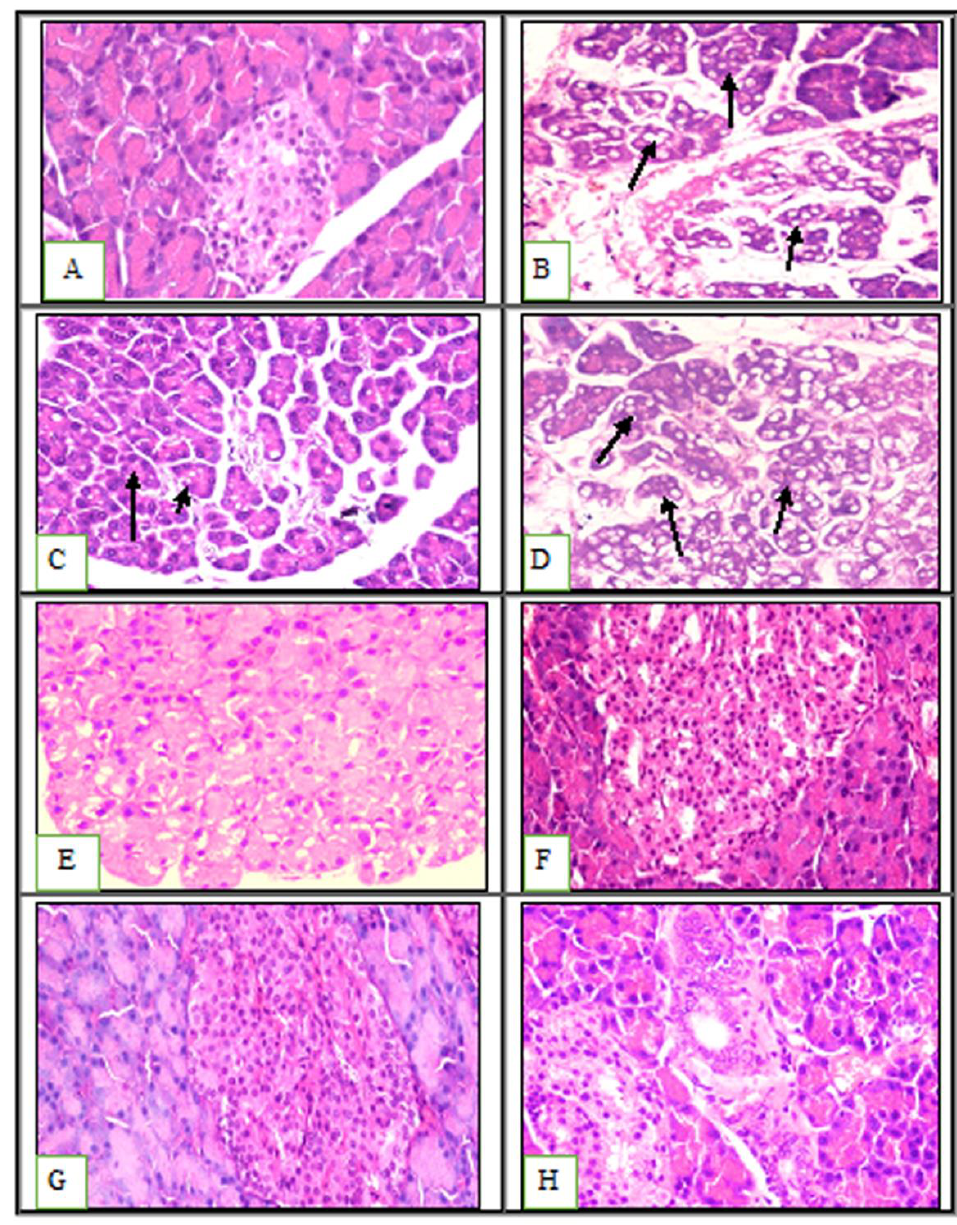
Figure 5. Histopathological examination of the pancreatic tissue. ( A ) Normal pancreatic tissue (H & E X400). ( B ) Massively vacuolated acinar epithelium (arrows) (H & E X400). ( C , D ) Partially vacuolated acinar epithelium (arrows). ( E – F ) Normal pancreatic tissue (H & E X400). ( A ) Negative control. ( B ) Positive control. ( C , D ) Green tea. ( E ) Chia seed. ( F ) Chitosan. ( G ) Probiotic. ( H ) Mixture. A 50 µM bar scale was used for all the tissues.